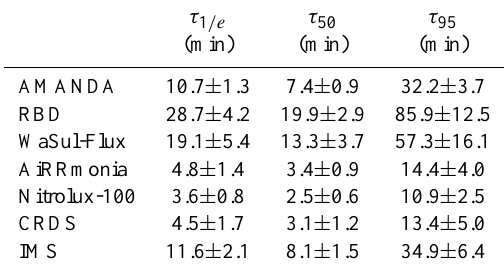
Table 9. Analysis of the response time of AMANDA, RBD, WaSul- Flux, AiRRmonia, Nitrolux-100, CRDS and IMS in comparison to c-QCLAS with corresponding statistical